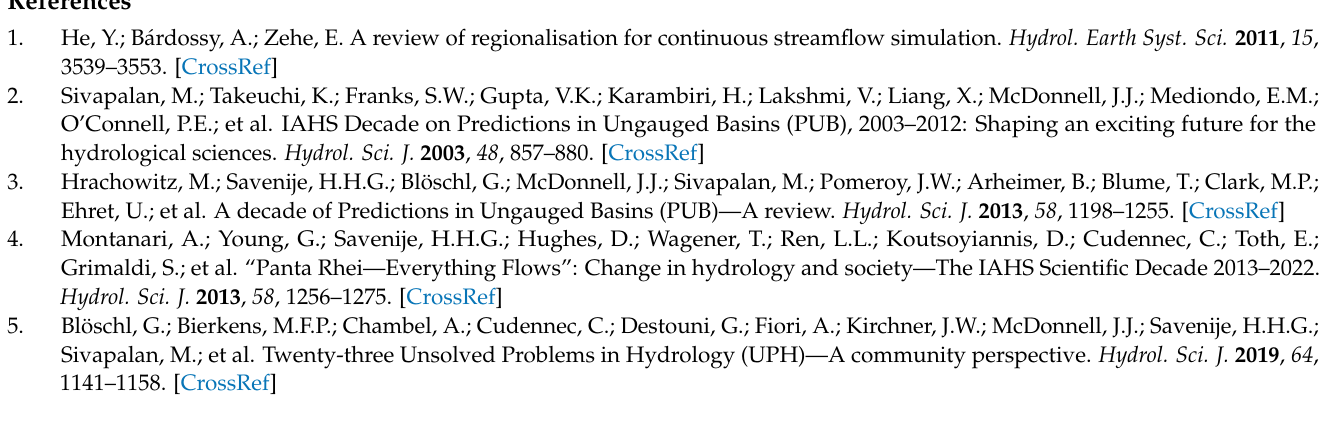
Figure A2. Summaries over the 511 investigated catchments of the estimated daily temperature, precipitation and streamflow features (part 2). For the explorations and predictions, these dynamic catchment features were merged with static catchment features. The displayed feature abbreviations are explained in Section